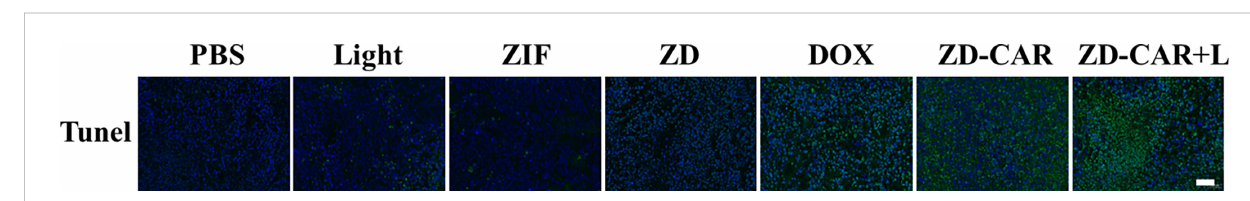
FIGURE 15 Fluorescence microscopy images of Tunnel-stained (green) tumor tissues after various treatments. (Scale bar is 50 m m).